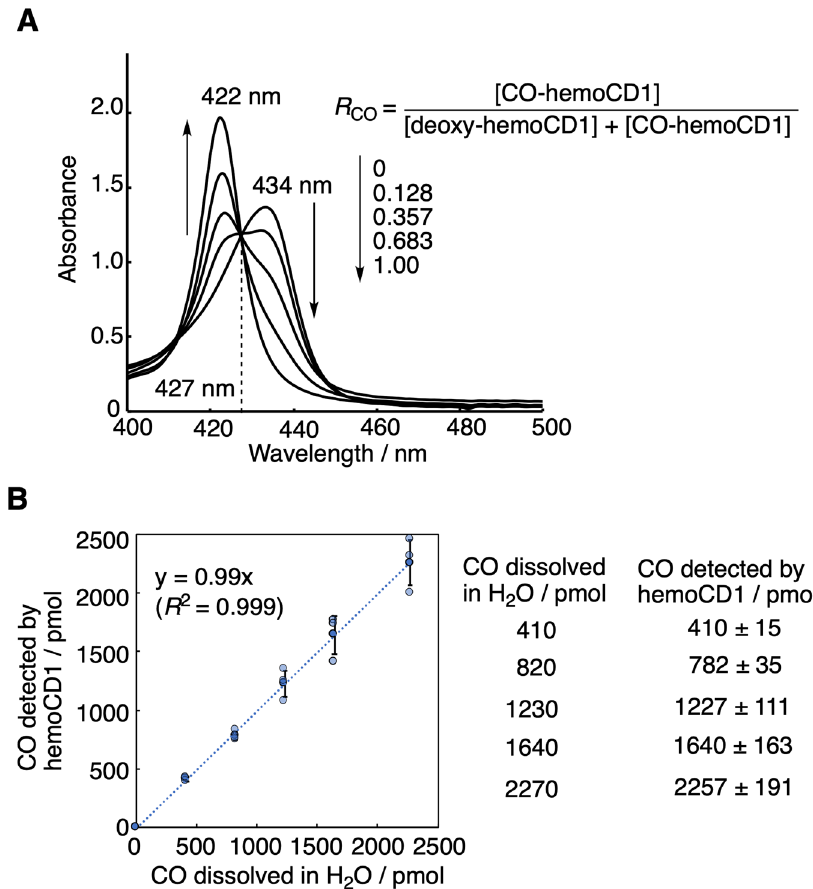
Fig. 3 Spectroscopic quanti fi cation of CO in aqueous solution using hemoCD1. A UV – vis spectra of hemoCD1 (6.0 μ M) after exposure to various amounts of CO in PBS (1 ml) at pH 7.4 and 25 °C. R CO values were calculated using Eq. (1). B The plot of known amounts of CO dissolved in water versus the quanti fi ed values of CO determined by the hemoCD1 assay. Data are shown as mean ± SD ( n = 3). Table 1 Molar absorption coef fi cients ( ε /M − 1 cm − 1 ) of hemoCD1 used in this